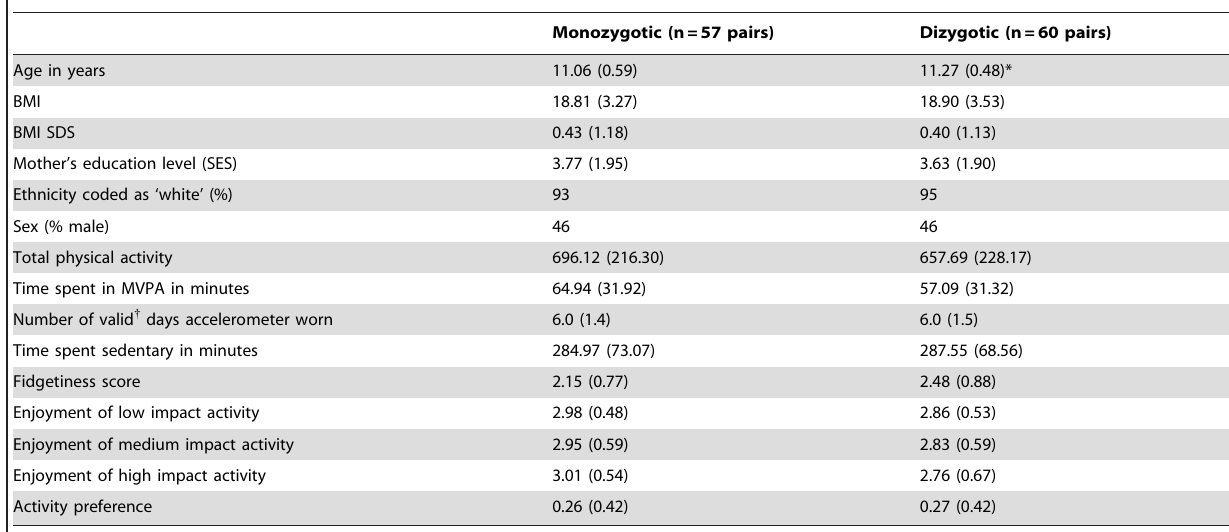
Table 1. Baseline characteristics of twins stratified by zygosity.